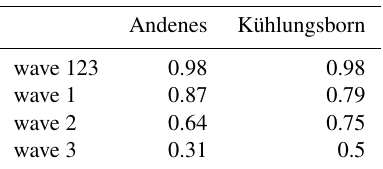
Table 1. Correlation coefficients between the original time series and the reconstructed time series for all available winters for An- denes and